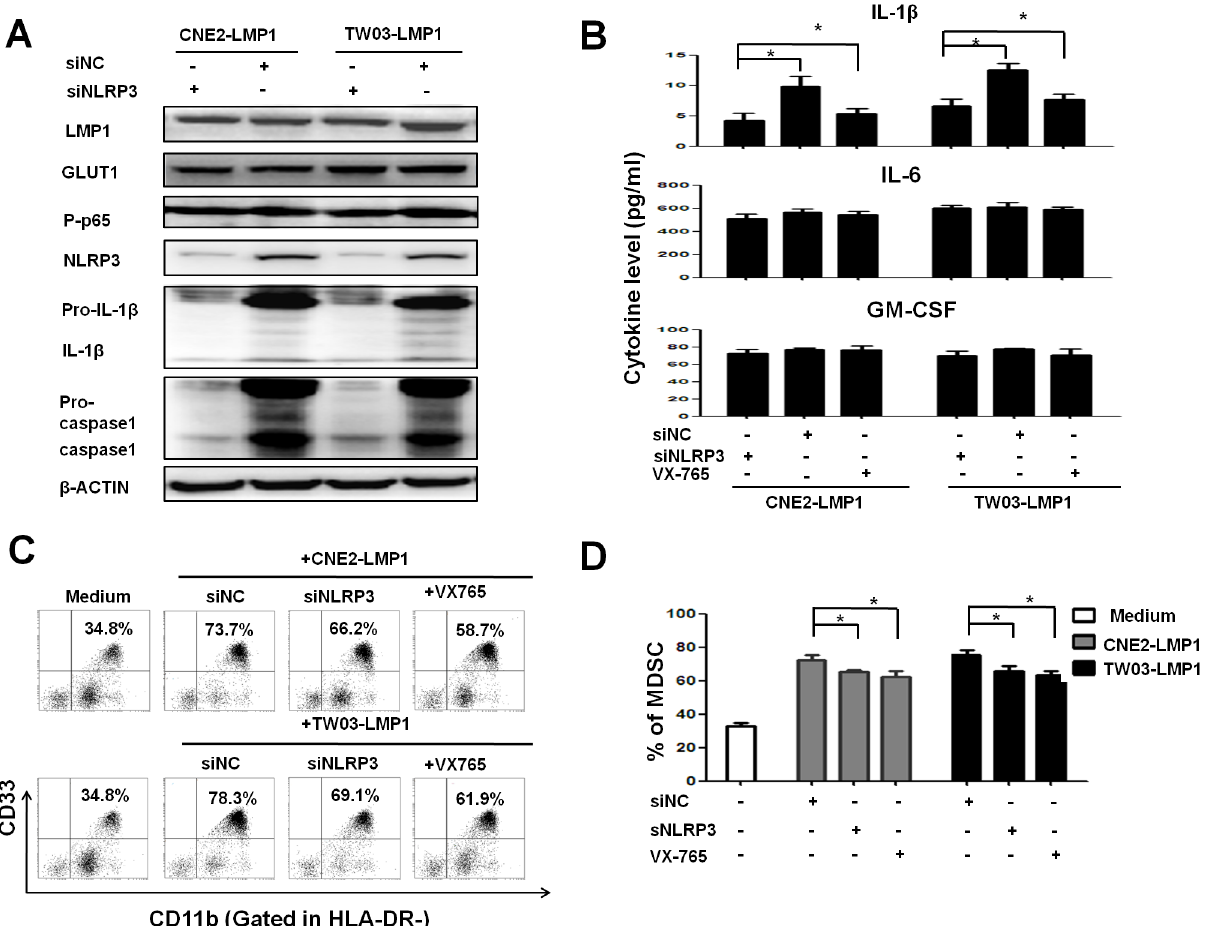
Fig 5. NLRP3 expression was involved in the accumulation of NPC-LMP1-mediated MDSCs. ( A ) Representative immunoblots of CNE2-LMP1 and TW03-LMP1 cells treated with siNC or siNLRP3 and stainedwith the indicatedantibodies(n = 3). ( B ) Secretion of the cytokines IL-1 β , IL-6 and GM-CSF from NPC-LMP1 cells followingtreatment with si-NLRP3, siControl(siNC) or VX-765 was determinedvia ELISA. ( C ) Blockadeof NLRP3 decreased the differentiation of HLA-DR - CD11b + CD33 + MDSCs mediated by NPC-LMP1. Representative data from 5 independentexperiments are shown. ( D ) Statistical analysisof the percentage of CD33 + CD11b + HLA-DR - MDSCs mediated by CNE2-LMP1 or TW03-LMP1 cells followingtreatment with si-NLRP3, siNC or VX-765. Representative data from 3 independent experiments are